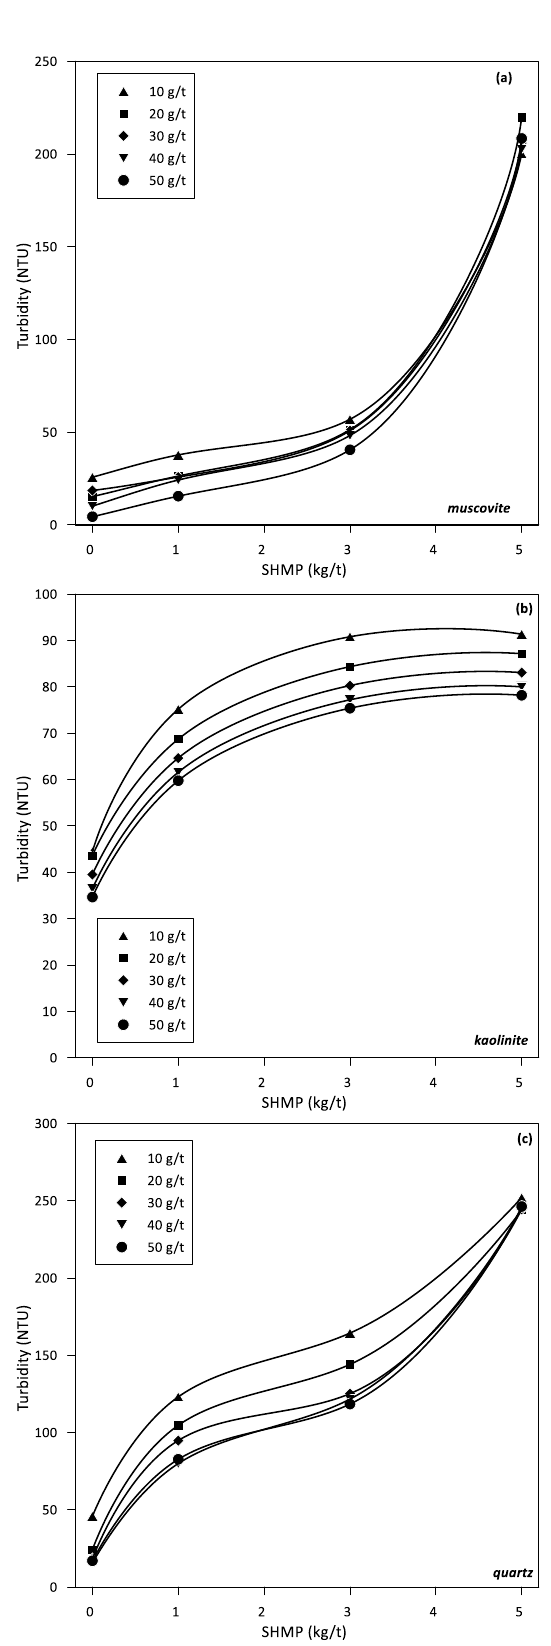
Figure 3. Supernatant turbidity of muscovite ( a ), kaolinite ( b ), and quartz ( c ) in seawater at pH 9 (30% solids) as function of SHMP concentration in seawater at pH 9 at different flocculant concentrations (in g/t).